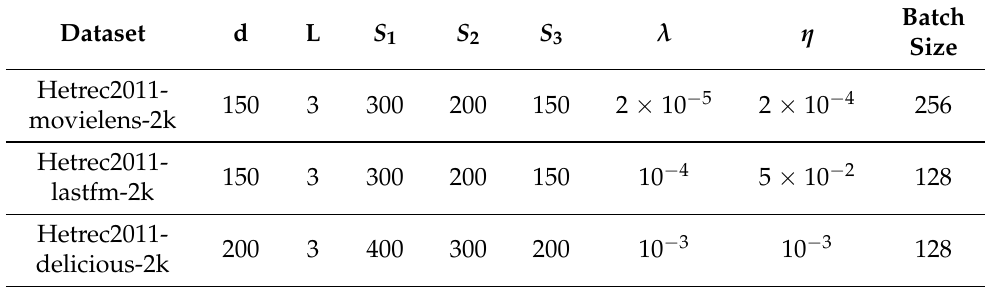
Table 3. Hyperparameter